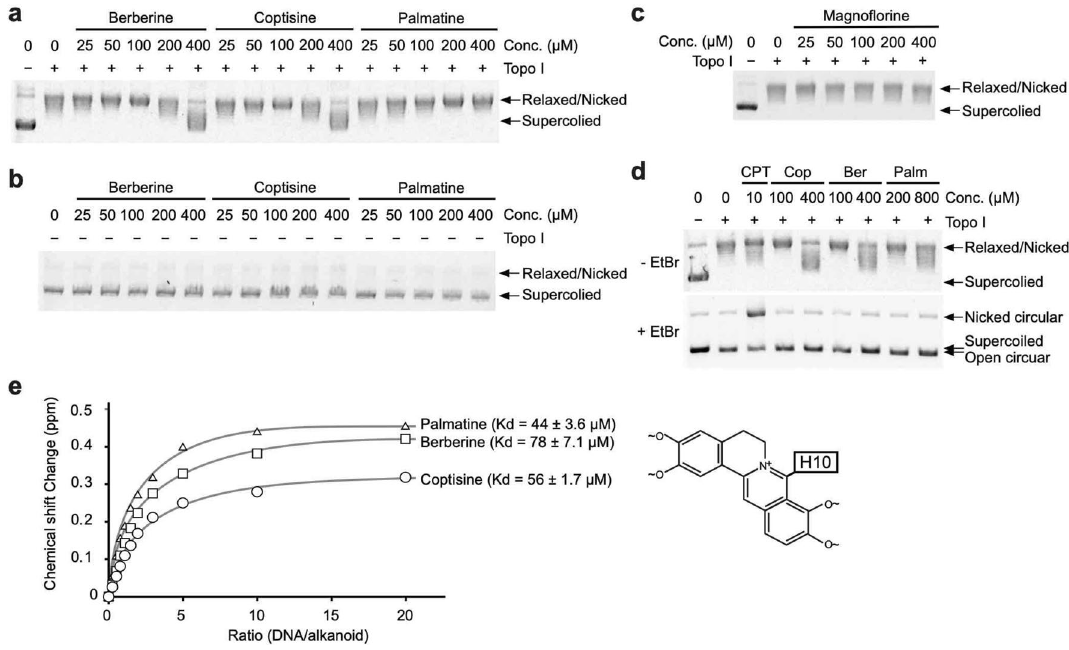
Figure 4. Analysis of Topo I inhibition by BIAs in vitro. ( a,b ) Inhibition of the relaxation activity of Topo I by berberine, coptisine, and palmatine. ( c ) Relaxation activity of Topo I after treatment with magnoflorine. ( d ) Detection of nicked DNA based on the effects on the relaxation activity of Topo I by CPT, coptisine (Cop), berberine (Ber), and palmatine (Palm). ( d ) NMR titration curves, 1 H chemical shift changes versus the concentration of dsDNA, and dissociation constant (Kd) values for coptisine, berberine, and palmatine. The inset shows the proton in the alkaloid backbone used for the NMR